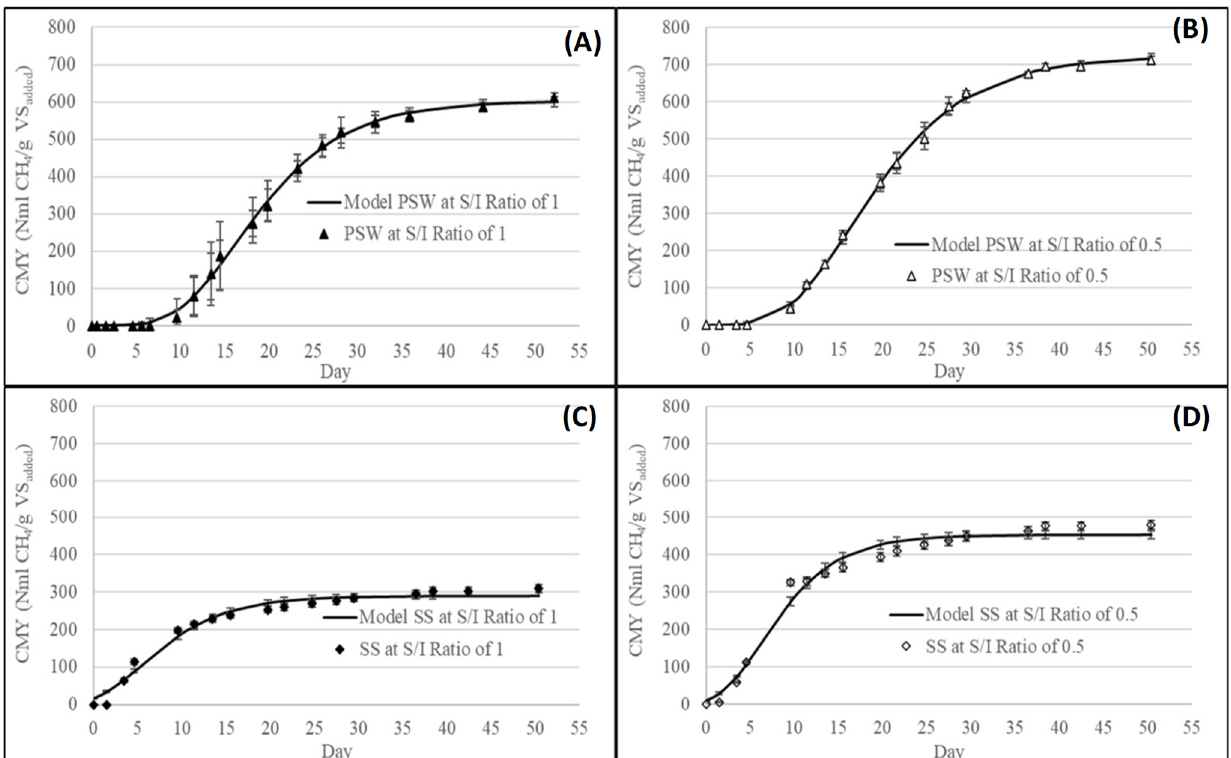
Figure 2. CMY estimated using the modified Gompertz formula (line) plotted against experimental CMY (bullet points) of SSW and SS. ( A ) SSW at an S/I ratio of 1, ( B ) SSW at an S/I ratio of 0.5, ( C ) SS at an S/I ratio of 1, and ( D ) SS at an S/I ratio of 0.5. PSW, pig slaughter waste equal to SSW.